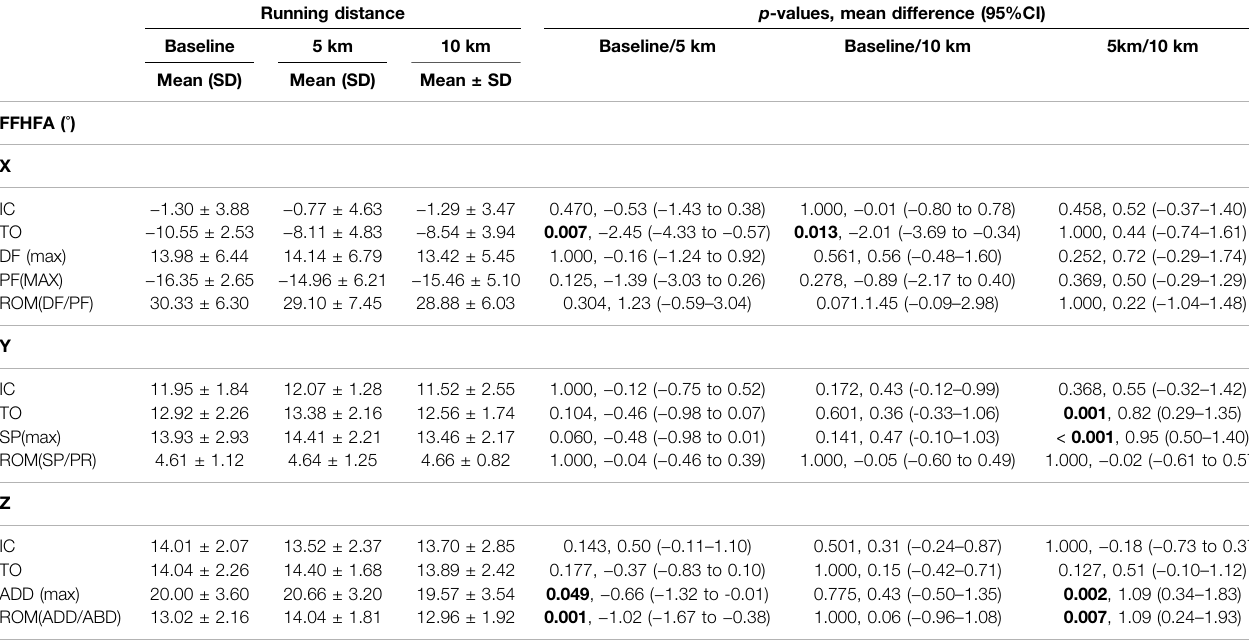
TABLE 1 | Forefoot with respect to hindfoot motion kinematics at baseline and immediately after 5 and 10 km of